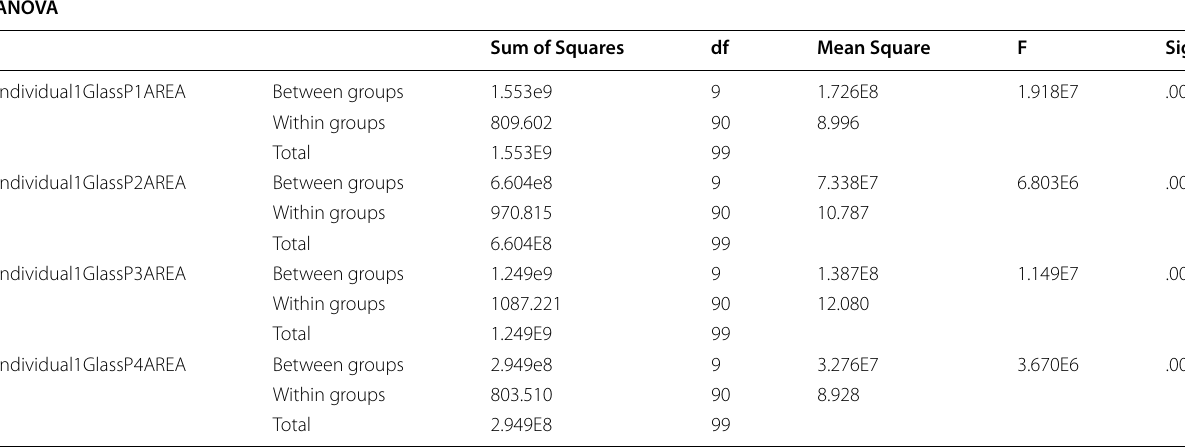
Table 4 Results obtained using ANOVA for fingerprints obtained from the left thumb of individual 1 on glass with “area” as the “dependent variable” ANOVA Sum of Squares df Mean Square F Sig.